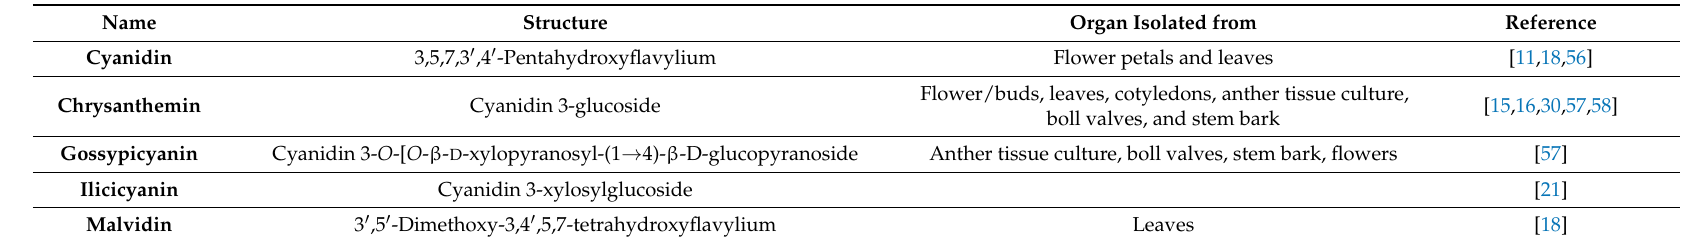
Table 3. Distribution of anthocyanidins and anthocyanins in Gossypium hirsutum